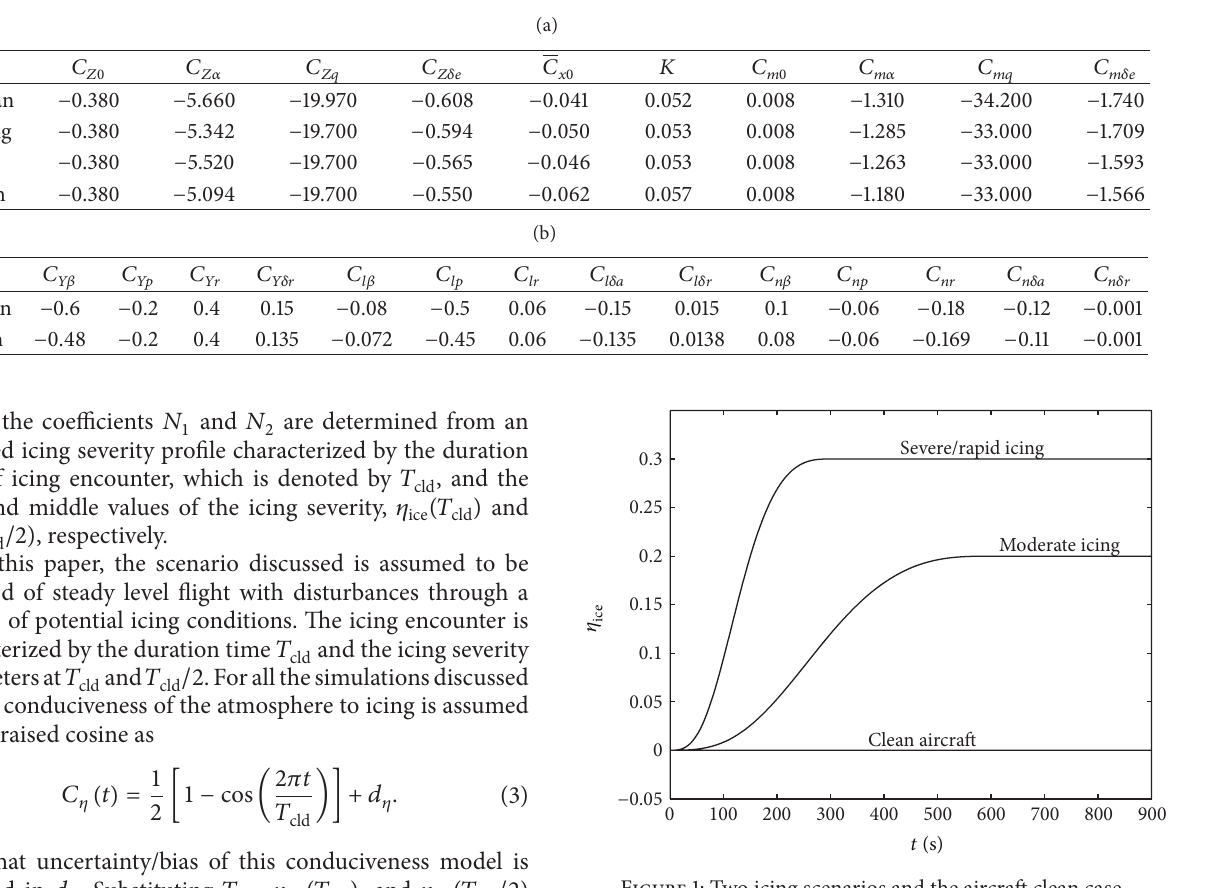
Table 1: Dynamic parameters of Twin Otter in clean and iced configurations.